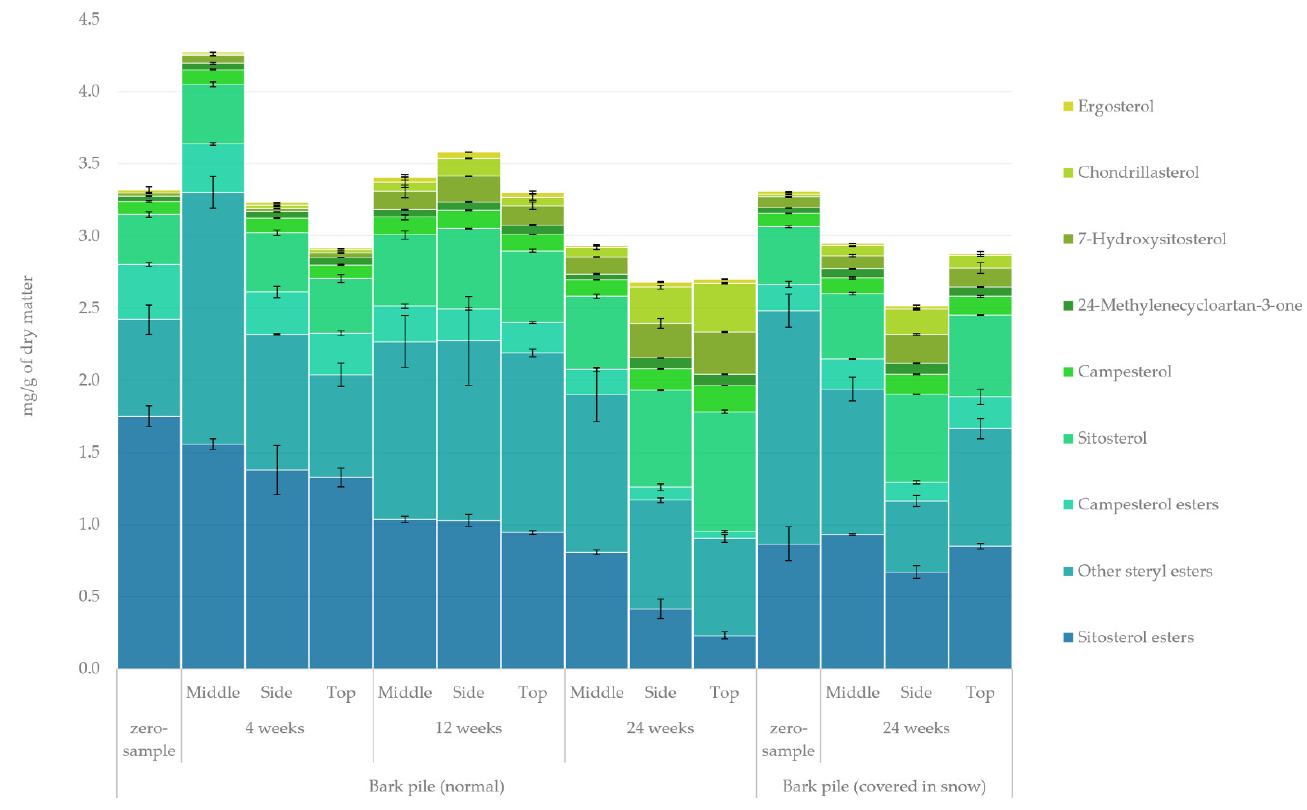
Figure 8. Quantified amounts of sterols and steryl esters in the lipophilic extracts of stored